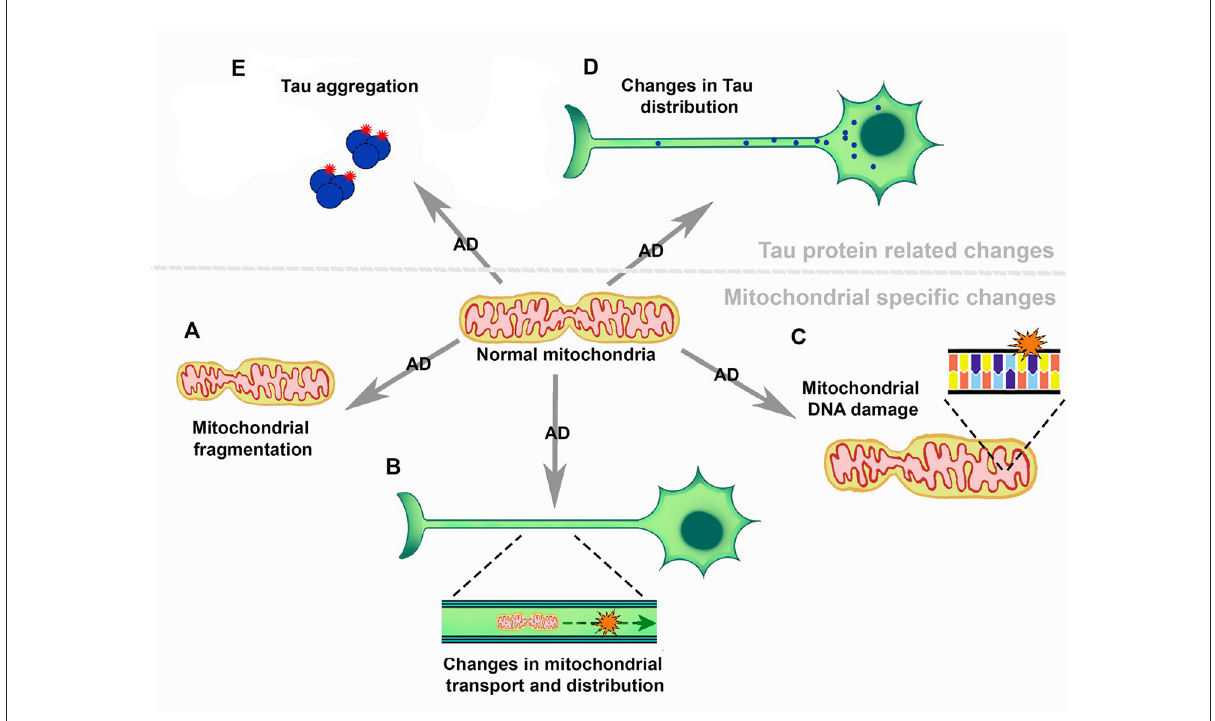
FIGURE2 The role of mitochondria in the development and progression of Alzheimer’s disease. (A) Mitochondrial fragmentation. (B) Mitochondrial transport and distribution across neurons. (C) Mitochondrial DNA damage. (D) Changes in Tau distribution and (E) Tau